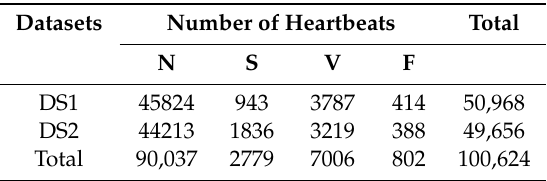
Table 2. Interpatient evaluation paradigm of the MIT-BIH arrhythmia database. MIT-BIH: Massachusetts